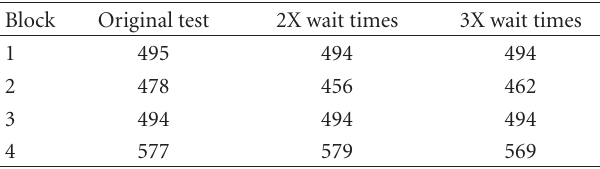
Table 2: Number of sensitive configuration bits detected in original and 2X and 3X wait time